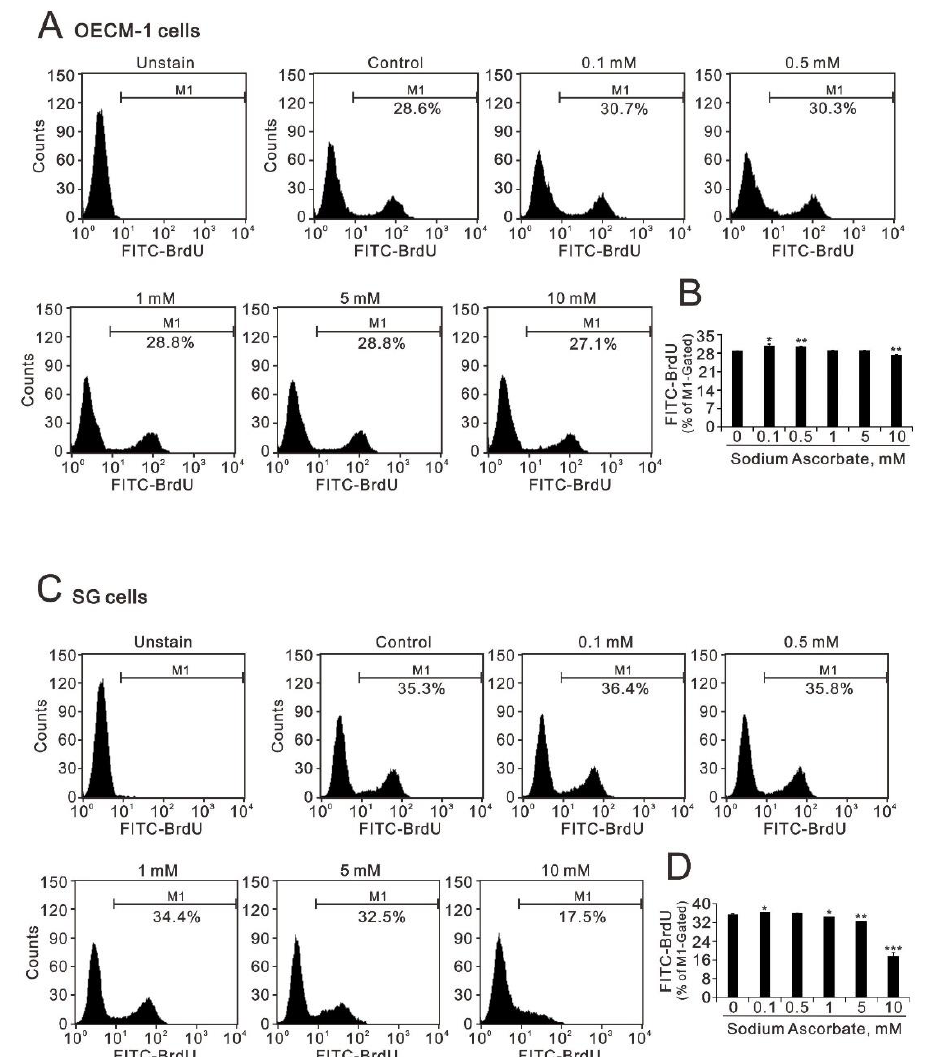
Figure 3. Effects of L-ascorbic acid and sodium ascorbate on the cellular proliferation in OECM-1 and SG cells. ( A , B ) OECM-1 (3.5 × 10 5 ) and ( C , D ) SG (3.5 × 10 5 ) cells were cultured in 6-well plates and treated with the indicated concentrations of sodium ascorbate for 4 h. They were then subjected to BrdU proliferation analysis. ( B ) and ( D ) Bars depict the mean ± SD of three independent experiments. Student’s t -tests were analyzed and compared with vehicle. * p < 0.05, ** p < 0.01, and *** p < 0.001.